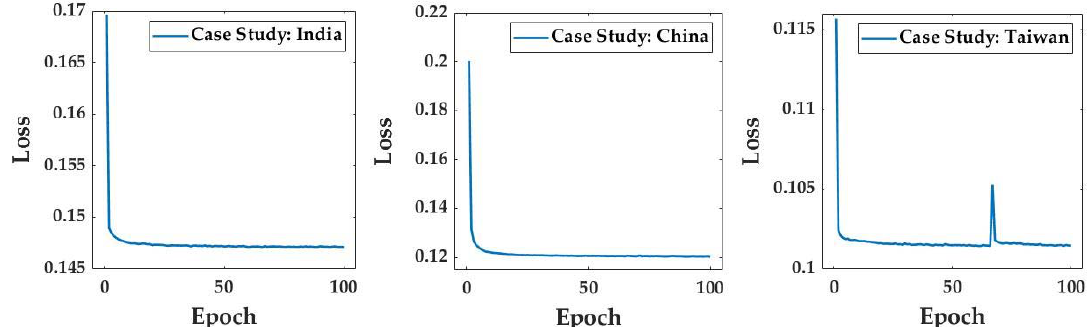
Figure 7. Reconstruction loss improvement during the training of the proposed CAEs in 100 epochs for cases in India, China, and Taiwan.